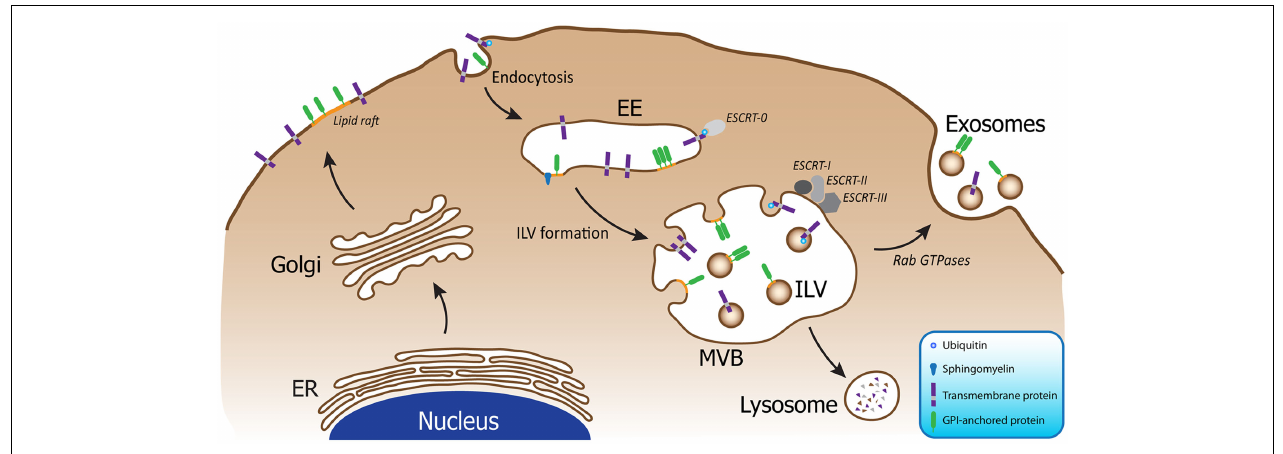
higher-ordered oligomerization; and segregation into microdomains by ceramide. MVBs can then fuse with lysosomes resulting in degradation of the cargo, or alternatively, the MVBs can fuse with the plasma membrane, resulting in release of the ILVs as exosomes, a process which is regulated by Rab